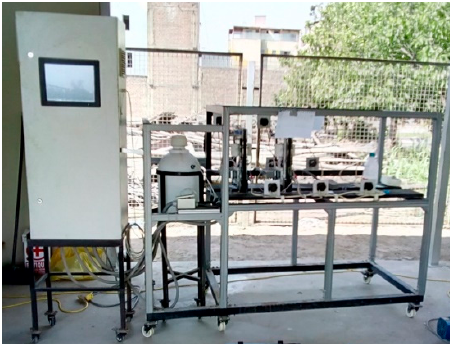
Figure 2. The ferrate(VI) reactor installed in the treatment plant.